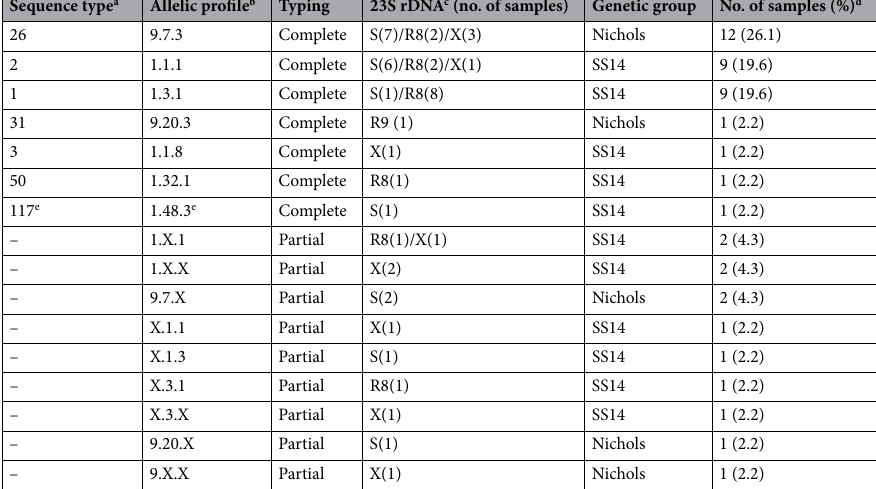
Table 2. MLST allelic profiles for 34 fully typed and 12 partially typed lesion swab samples from patients attending a sexually transmitted infections clinic in Buenos Aires, 2015–2019. a According to the PubMLST database of Treponema pallidum subsp. pallidum 15 . b Allelic profiles are based on a three-number code: the first number corresponds to the allelic variant in the TP0136 locus, the second corresponds to the allelic variant in the TP0548 locus and the third corresponds to the allelic variant in the TP0705 locus. We used X to denote that the allelic variant was notdetermined. c S no mutation in 23S rDNA (sensitive), R8 A2058G mutation in 23S rDNA (resistance), R9 A2059G mutation in 23S rDNA (resistance), X not determined. The frequency (number) of each case is given in parenthesis. d Percentages calculated over the total number of typed samples (no. of fully typed samples + no. of partially typed samples). e Newly identified allelic profile, with alleles known from previous